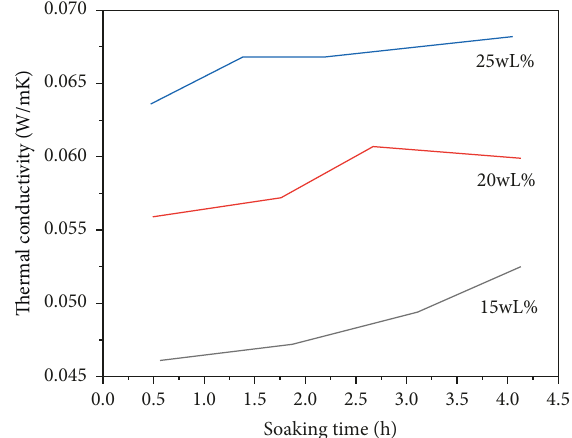
Figure 5: Effect of different soaking time on thermal conductivity of low-temperature foam glass-ceramic composites obtained by different